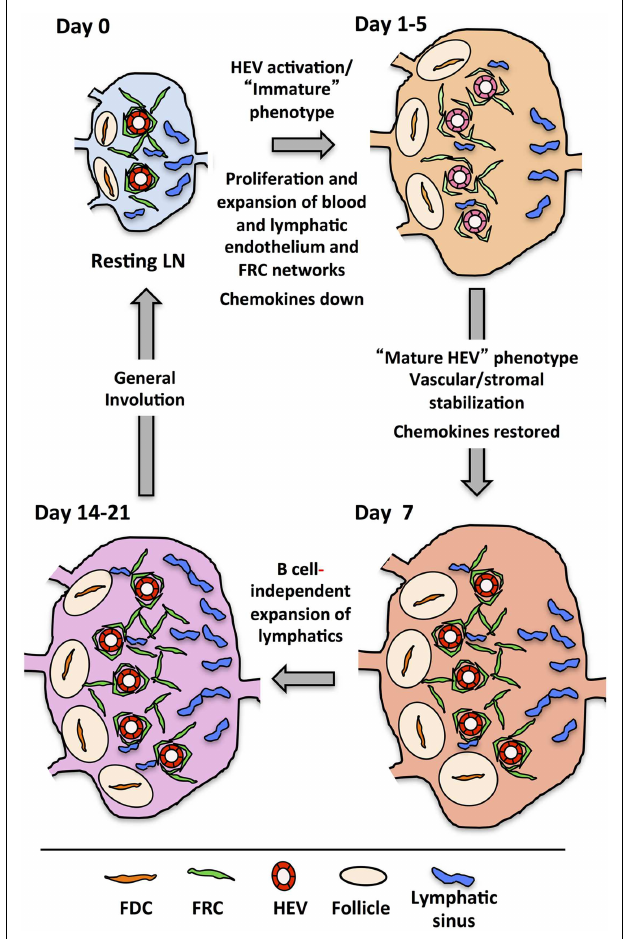
FIGURE 5 | Drawing shows the cycle that lymph nodes transit from resting to reactivity with some of the changes occurring at each stage . The actual timing of each stage will depend on the nature of the reactive trigger, e.g., immune complex, innate stimuli, virus, etc., and its subsequent